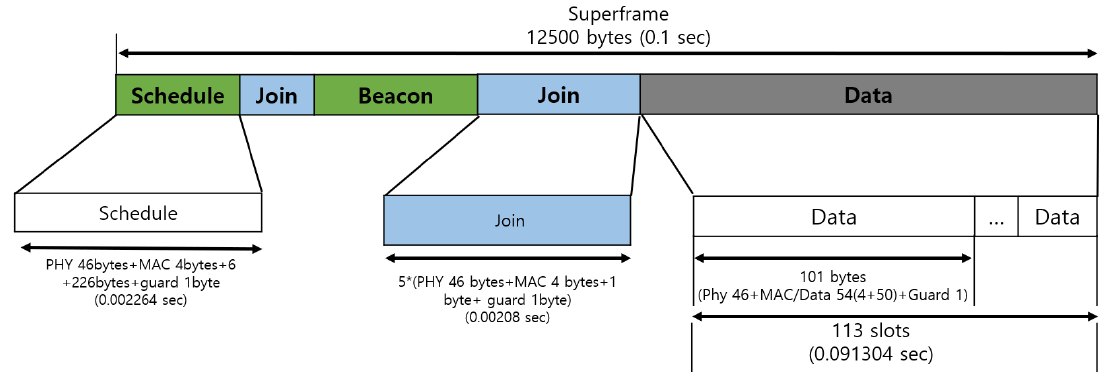
Figure 8. IB-MAC superframe